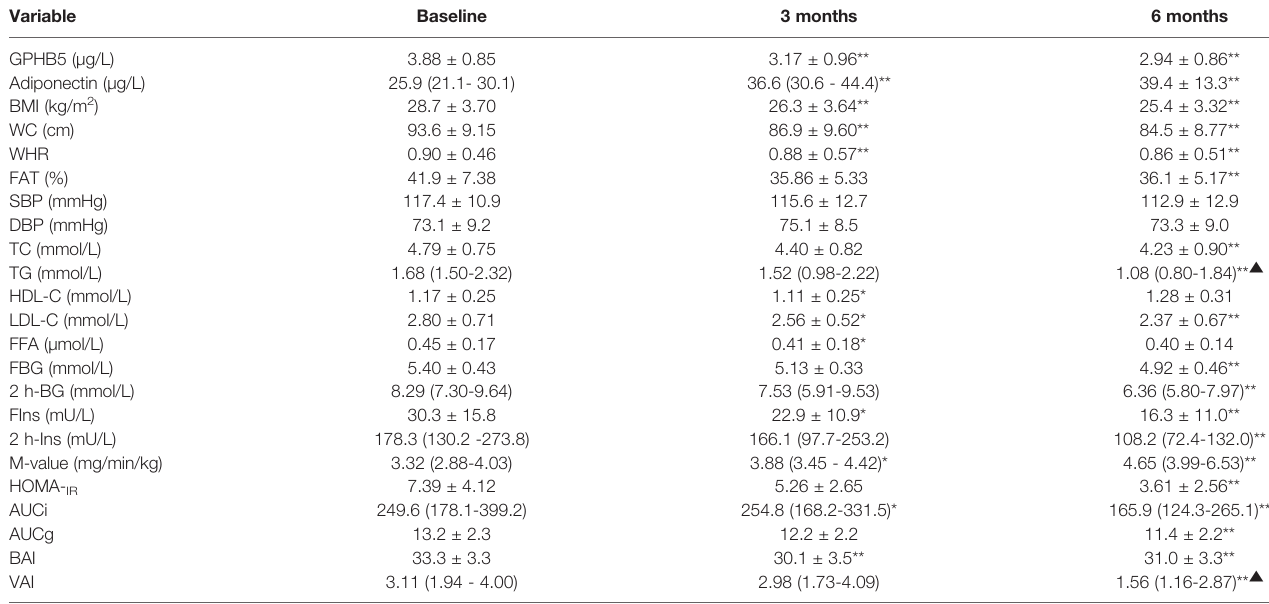
TABLE 3 | Main clinical and metabolic features pre- and post-treatment with GLP-1RA in obese individuals with IR.